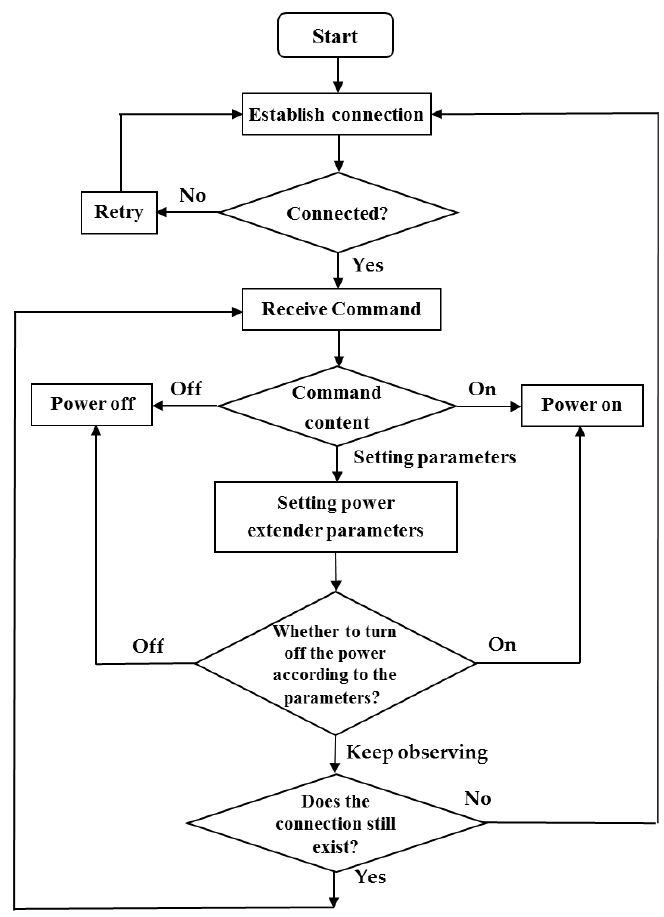
Figure 2. Flowchart of the system process.